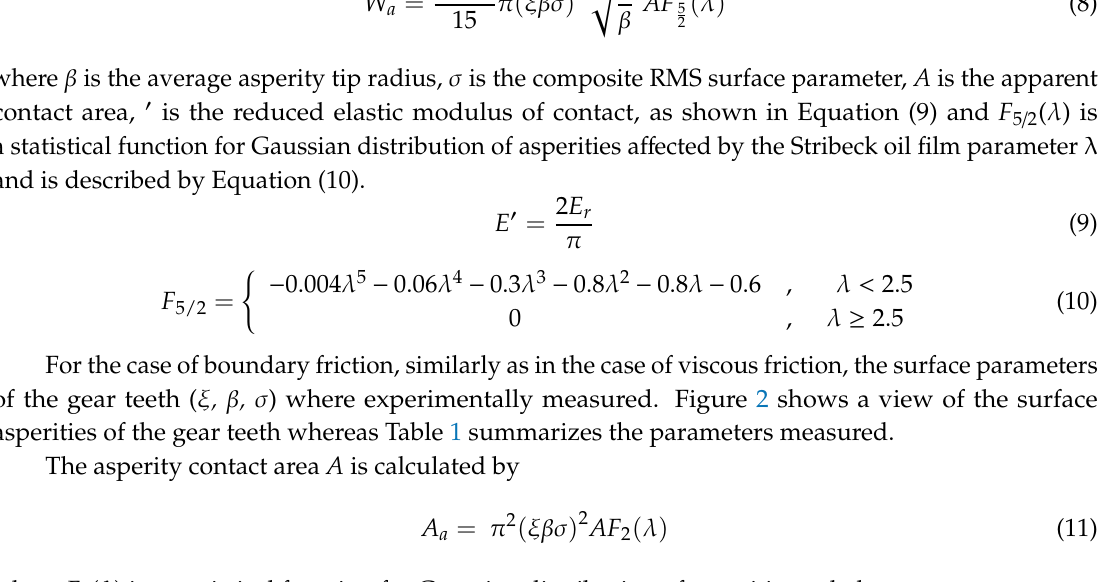
Table 1. Surface parameters for the gear teeth.